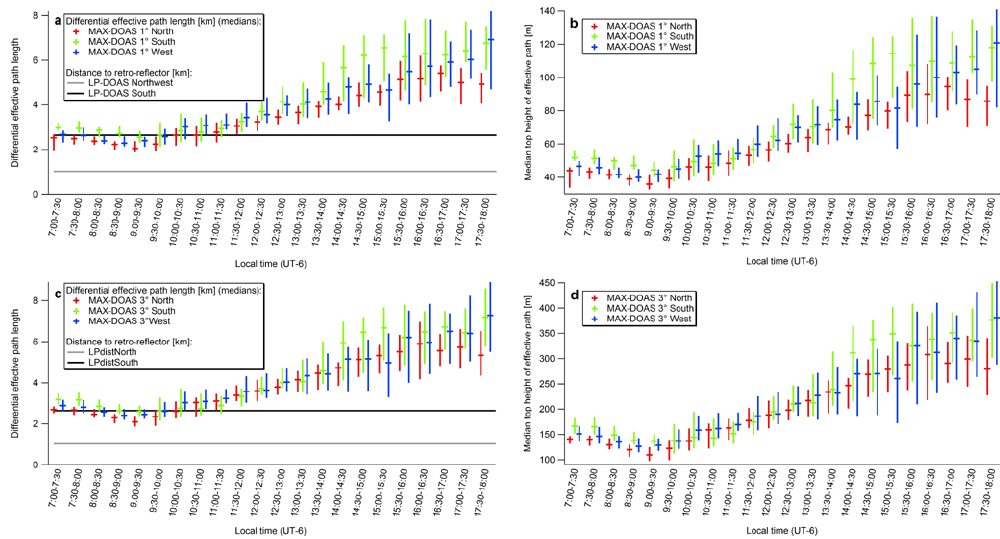
Fig. 9. Horizontal ( a and c ) and vertical ( b and d ) expansion of the MAX-DOAS measurements for 1 ◦ ( a and b ) and 3 ◦ ( c and d ) elevation angle.